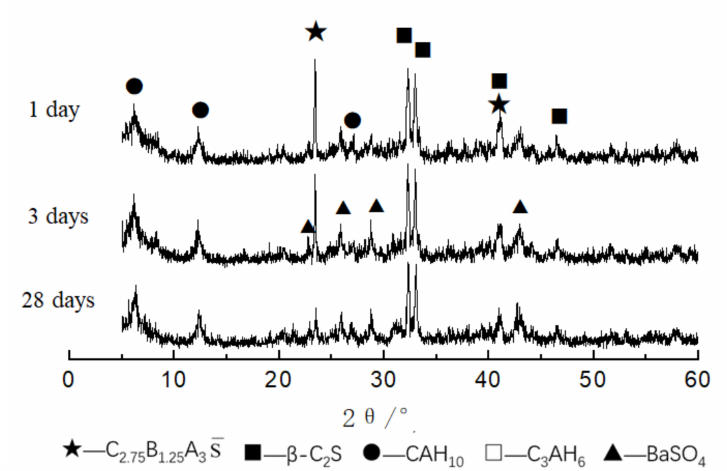
Figure 15. XRD patterns of sample CF1 at different hydrated